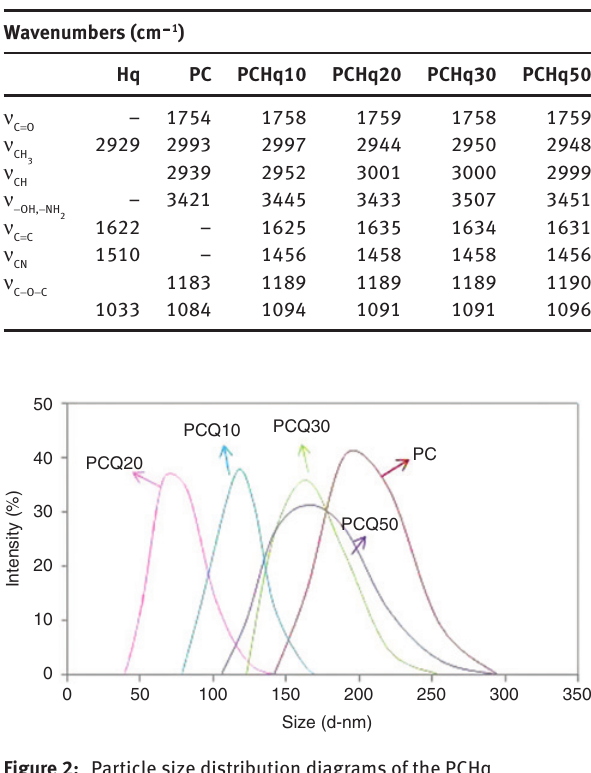
Figure 2: Particle size distribution diagrams of the PCHq nanoparticles using different Hq content.